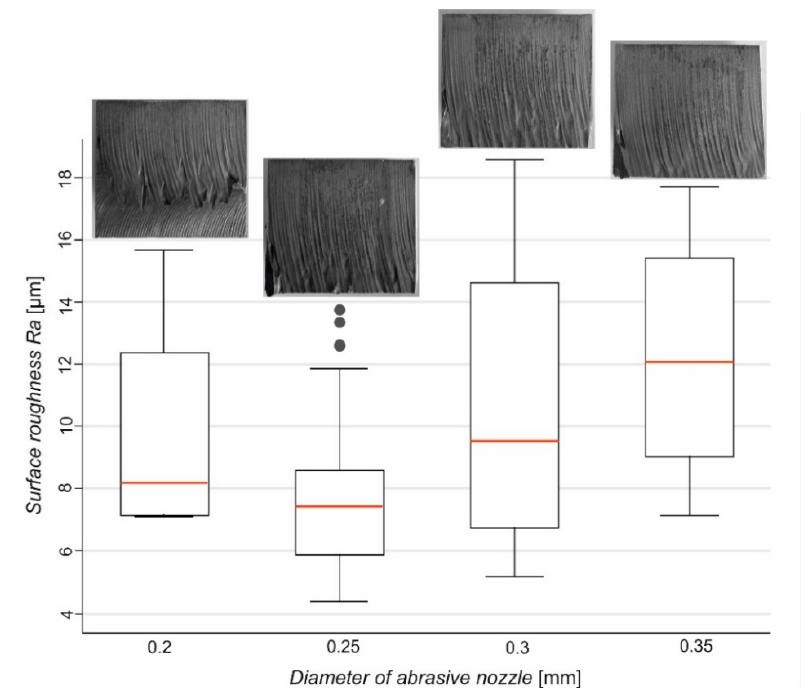
Figure 6. Effect of abrasive nozzle diameter on the surface roughness value Ra. Figure 6. E ff ect of abrasive nozzle diameter on the surface roughness value Ra